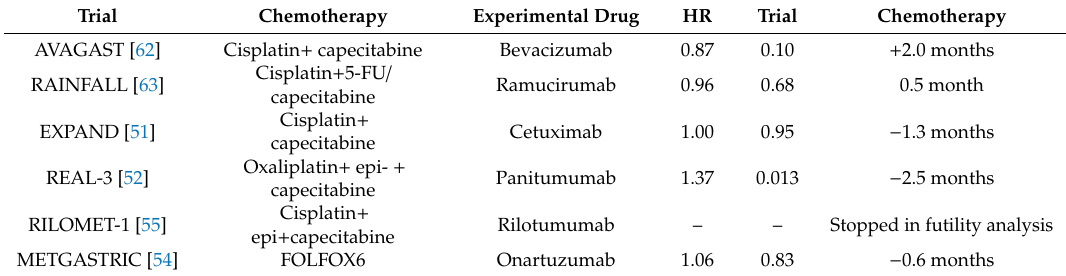
Table 3. Randomized trials targeting angiogenesis, EGFR and MET pathways in first line in